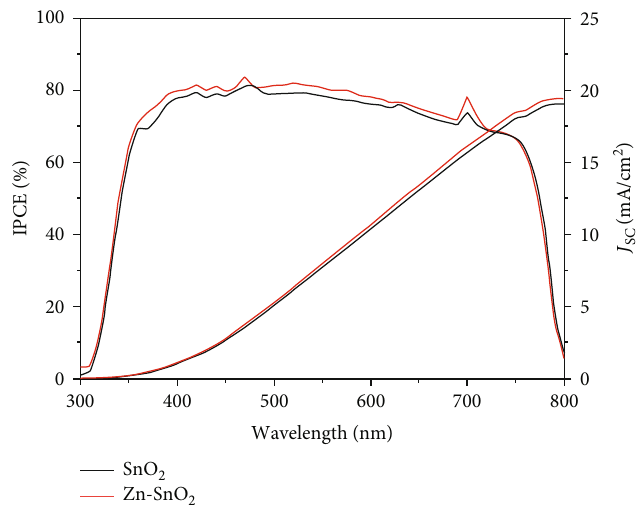
Figure 9: IPCE and current integral curves based on pure SnO